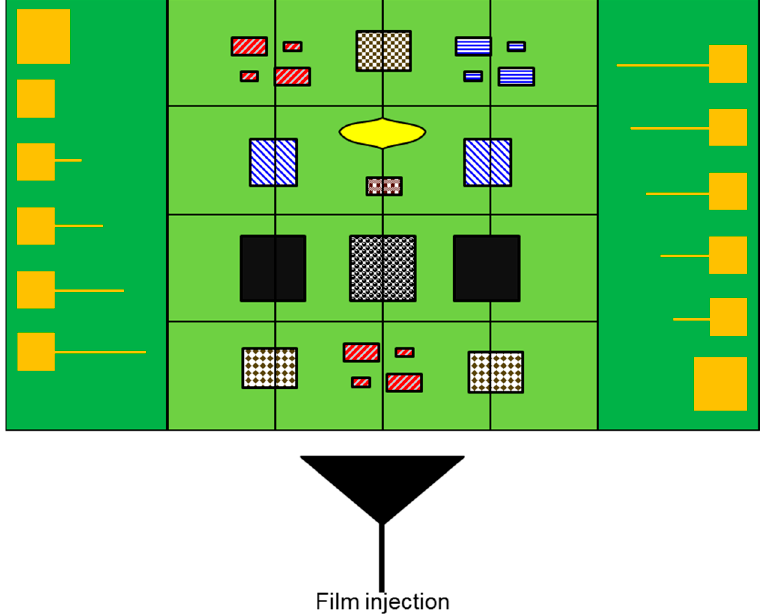
Figure 2. Conception of the electronic assembly to be encapsulated. It involves a wide range of applied surface-mounted components. See legend in Table 1. Table 1. List of mounted electronic components on each printed circuit board (PCB).